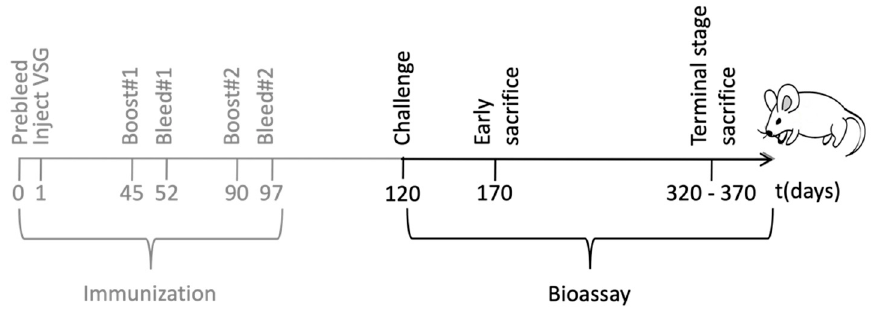
Figure 2. Schematic representation of the immunization and the bioassay. Female BALB/c mice were immunized with T. brucei expressing PrP-VSG (N = 11) or WT-VSG (N = 15). Serum was harvested at regular time points throughout the immunization and the possible protective role of the immunization was evaluated in a bioassay using a murine scrapie strain.